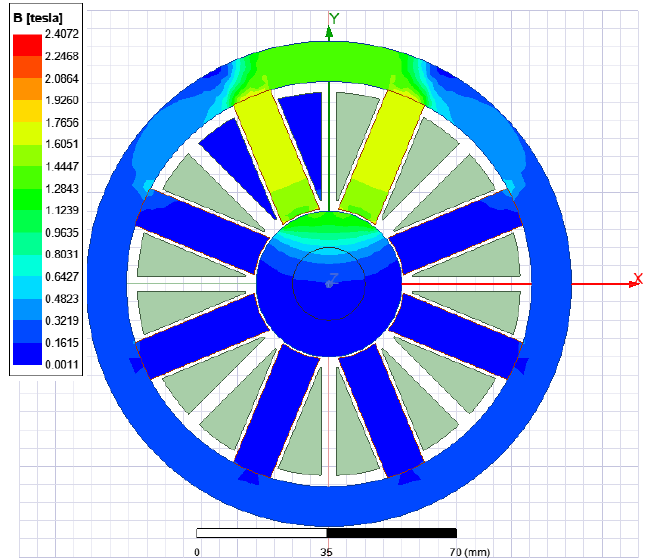
Figure 10. Results of calculating the magnetic field of an active magnetic suspension with a coaxial arrangement of the inner ring and the stator, at a nominal current in the windings of 40 A.